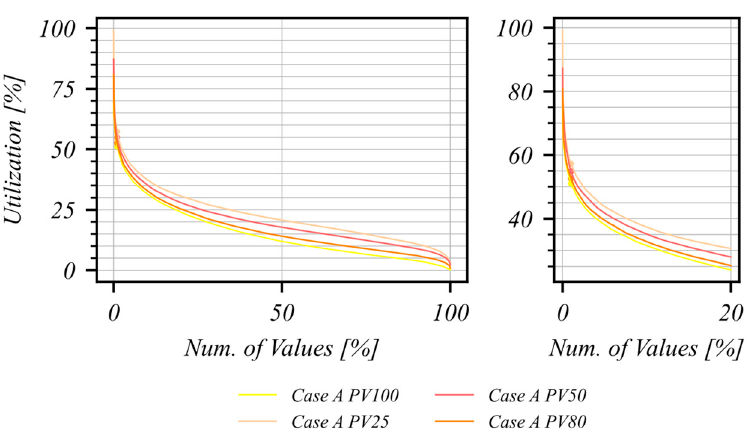
Figure 7. Impact of the PV expansion on the main transformer utilization.